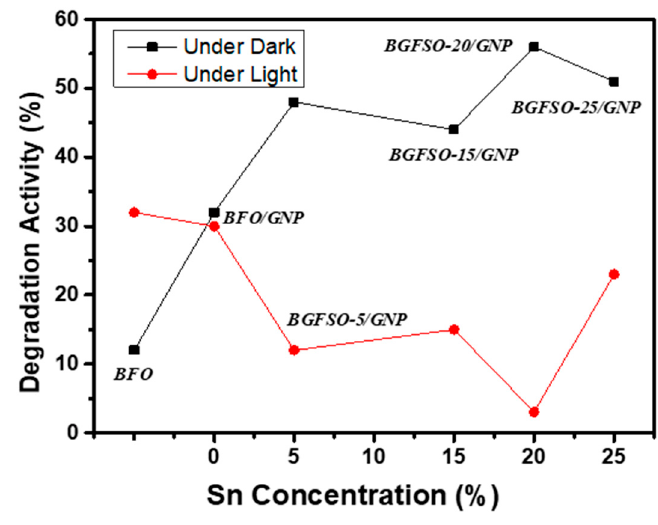
Figure 8. The dye degradation activity (%) vs. Sn concentration (%) inside BGFSO/GNP nanohybrids. Table 1. The % dye-removal of the nanohybrid catalysts under both, light and dark conditions. Catalyst